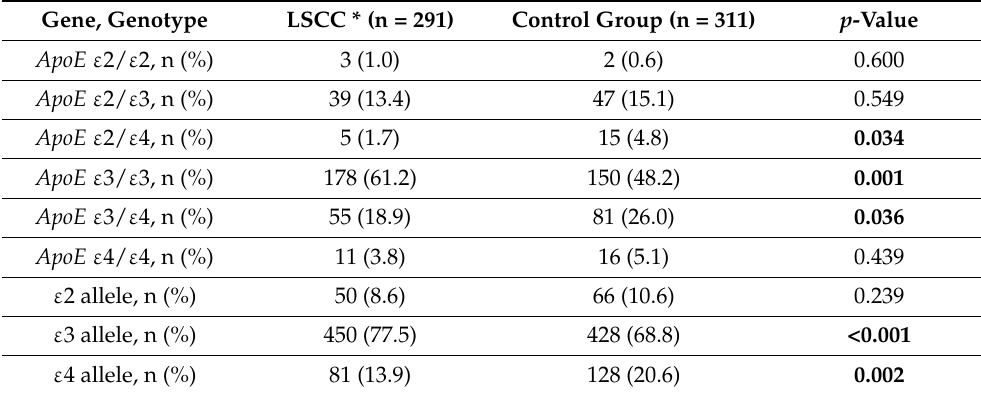
Table 2. Distribution of ApoE genotypes and alleles between patients with LSCC and control group. Gene,